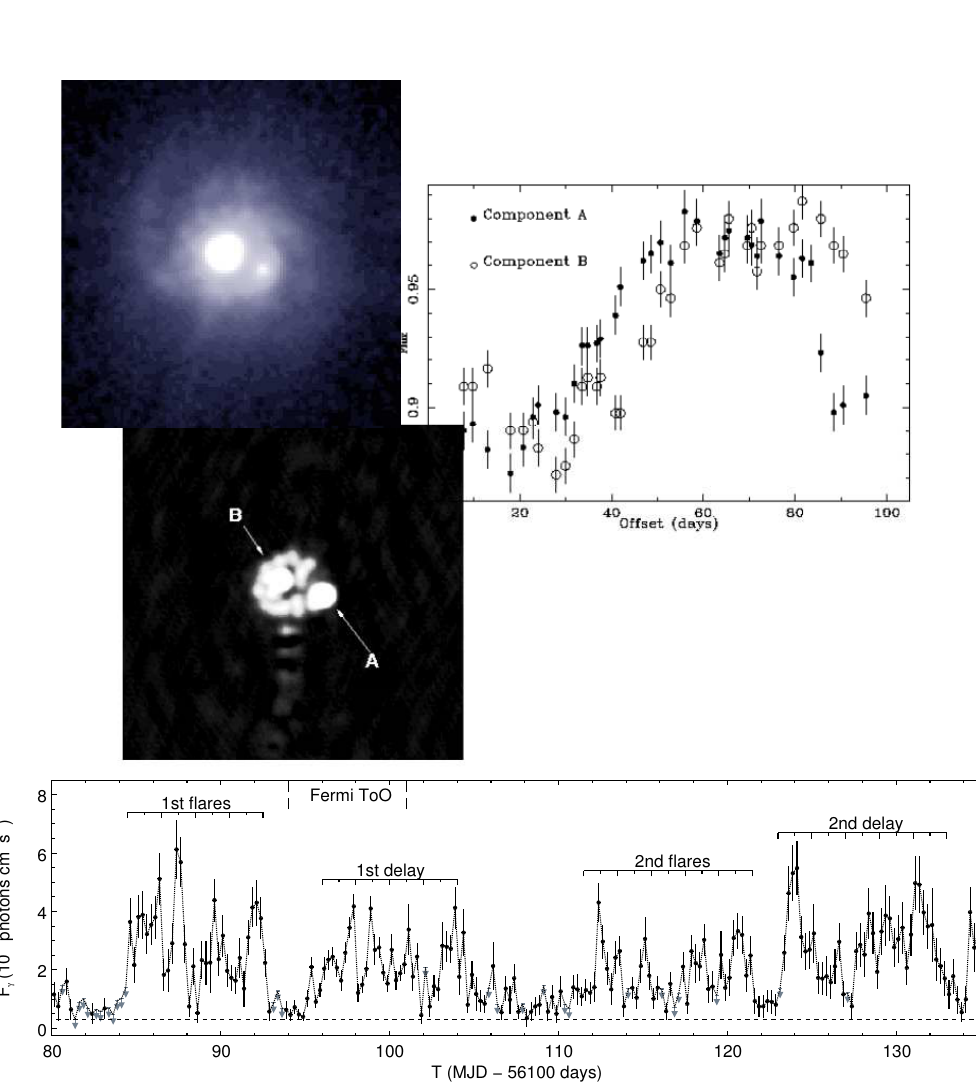
Figure 5: The lens system JVAS B0218+357. Top right: the measurement of time delay of about 10 days from asynchronous variations of the two lensed images [16]. The upper left panels show the HST/ACS image [241] on which can be seen the two images and the spiral lensing galaxy, and the radio MERLIN+VLA image [17] showing the two images together with an Einstein ring. The bottom panel shows the 𝛾 -ray lightcurve [37], in which, although the components are not resolved, the sharpness of the variations allows a time delay to be determined (at 11.46 – 0.16 days, significantly greater than the radio time delay). Image reproduced with permission from [37]; copyright by